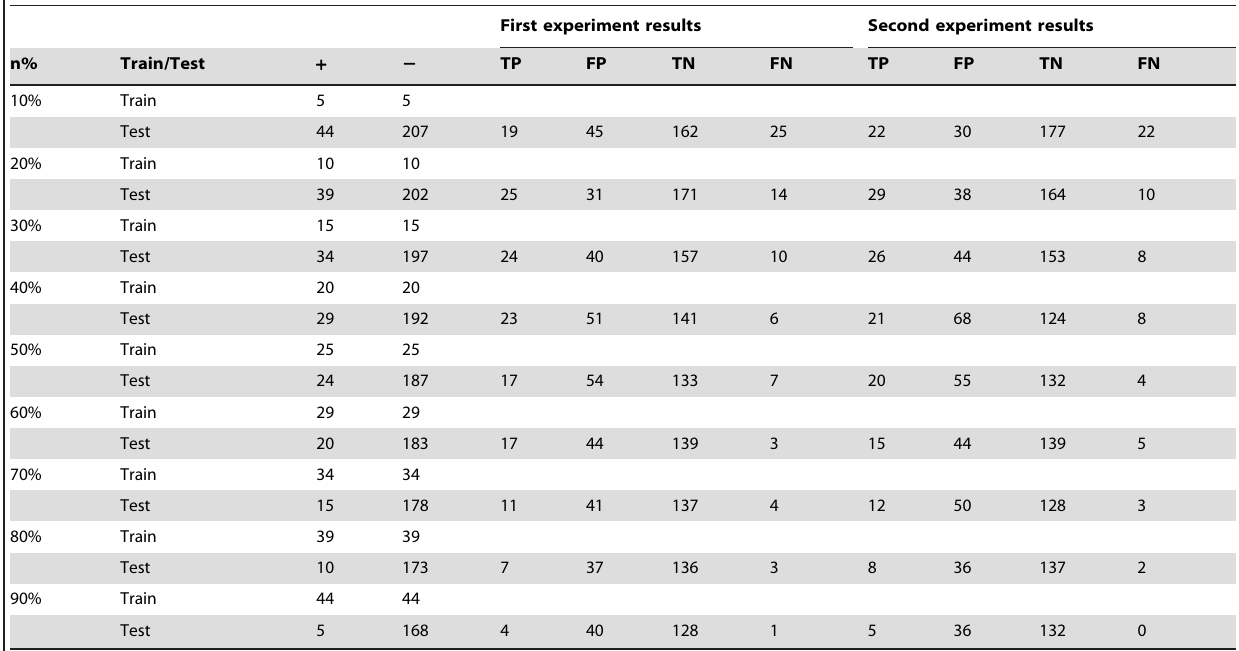
Table 4 . Results of the TP, FP, TN, and FN in MIHC by MLSVM.